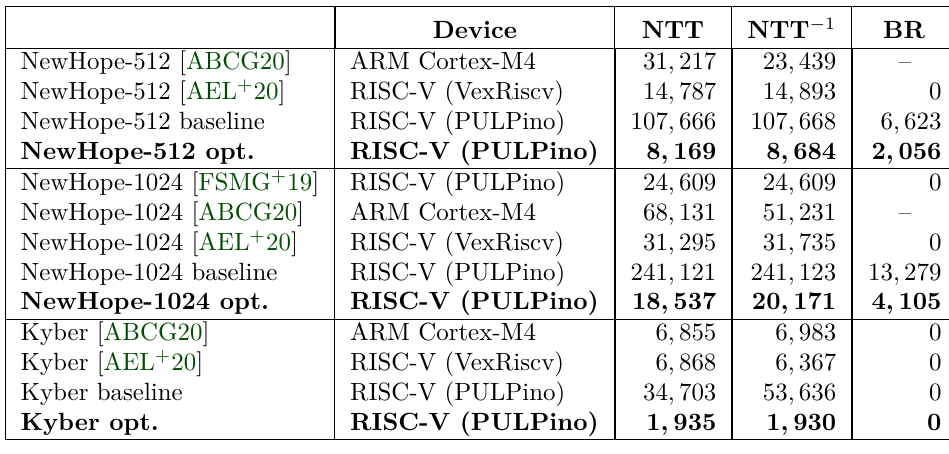
Table 2: Clock cycle count for the